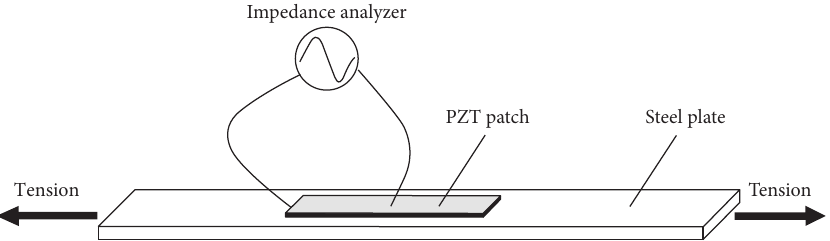
Figure 3: Schematic diagram of the simplified test.